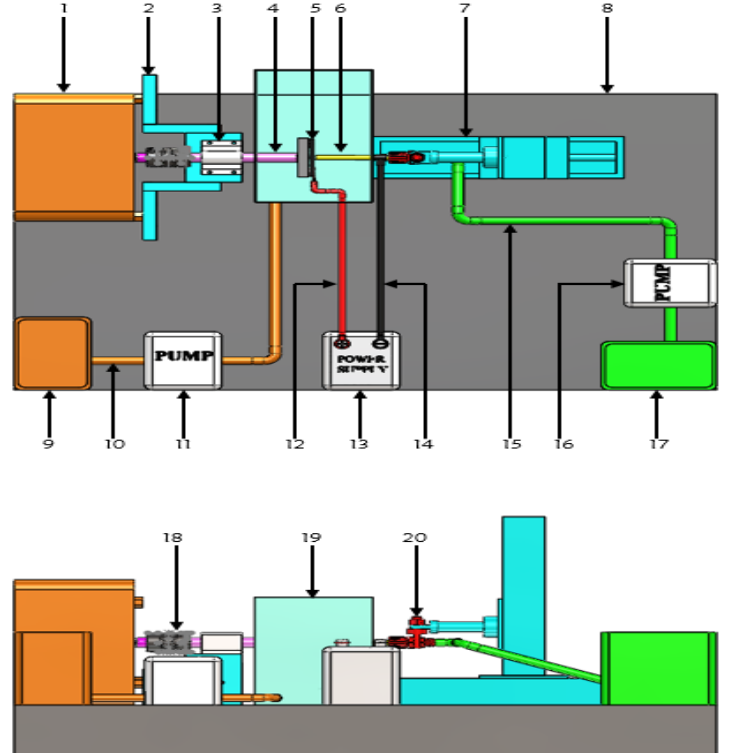
Figure 5 Front and top views of the laboratory horizontal ECM